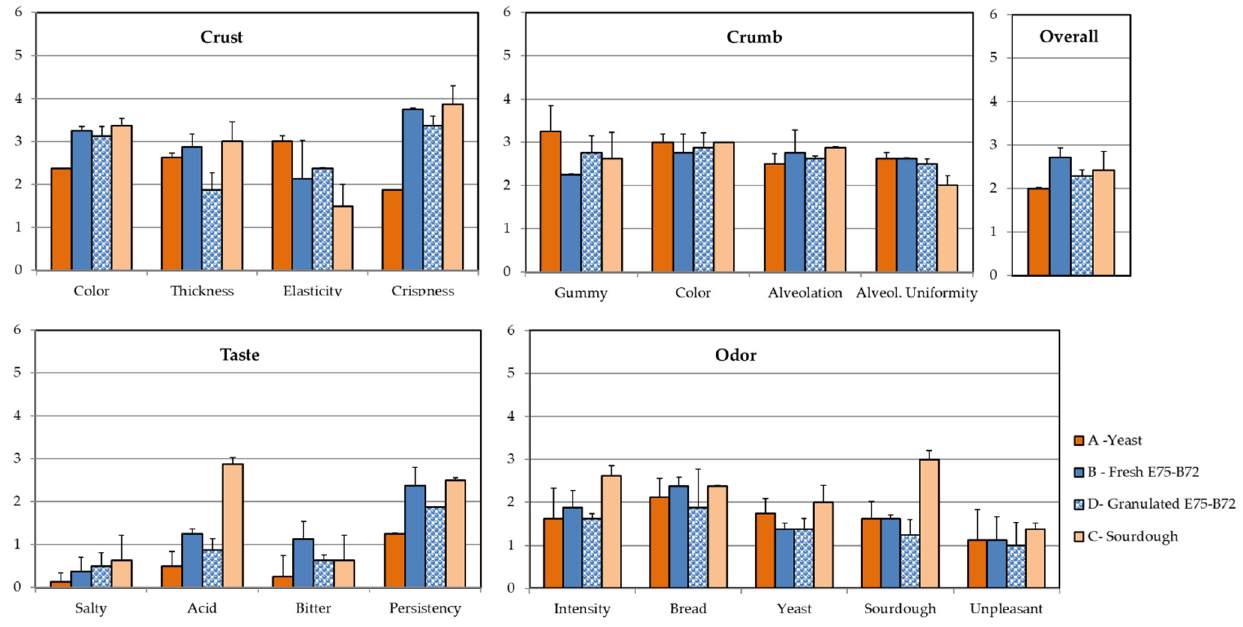
Figure 3. Sensorial descriptors mean scores and standard deviations of bread produced with natural sourdough, bakery yeast, or the starter E75-B72 as fresh or granulated cells. sourdough, bakery yeast, or the starter E75-B72 as fresh or granulated